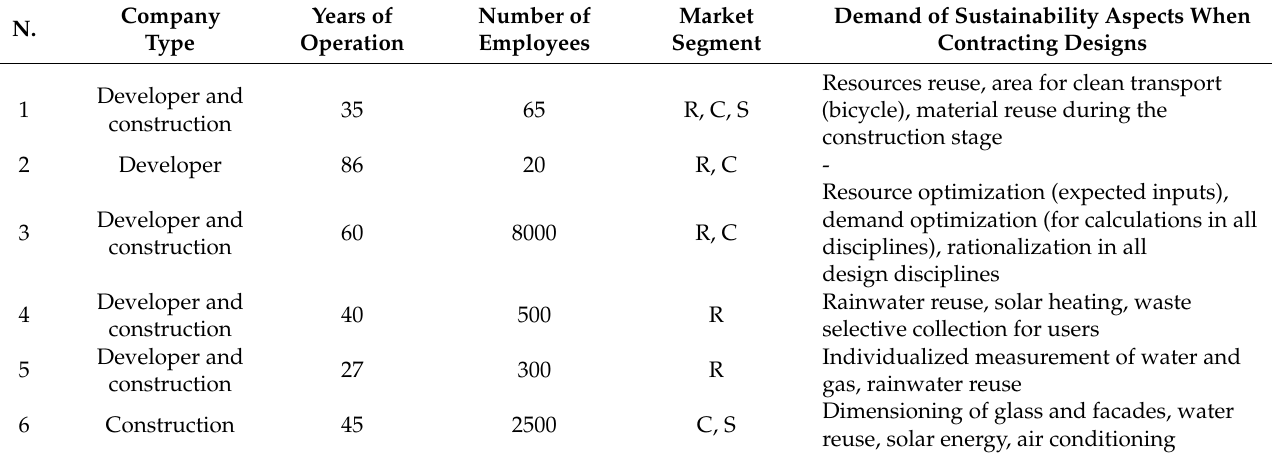
Table 3. Developers and/or construction companies (GF2) and sustainability demand.